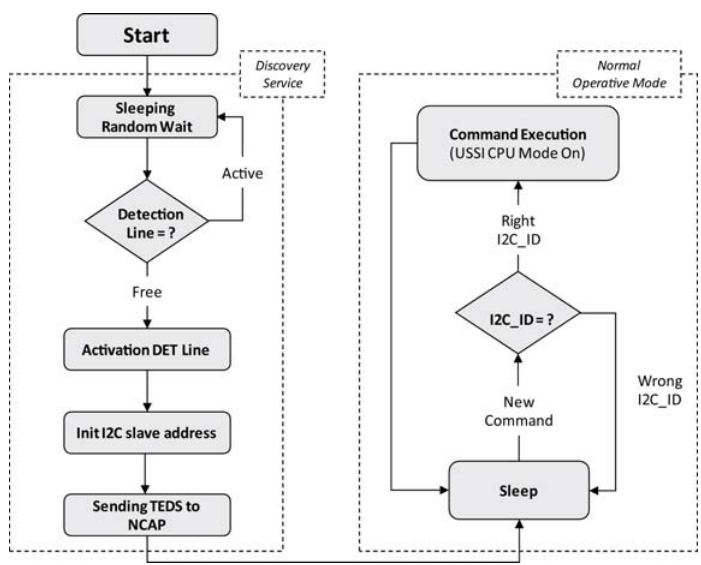
Figure 11. Firmware block